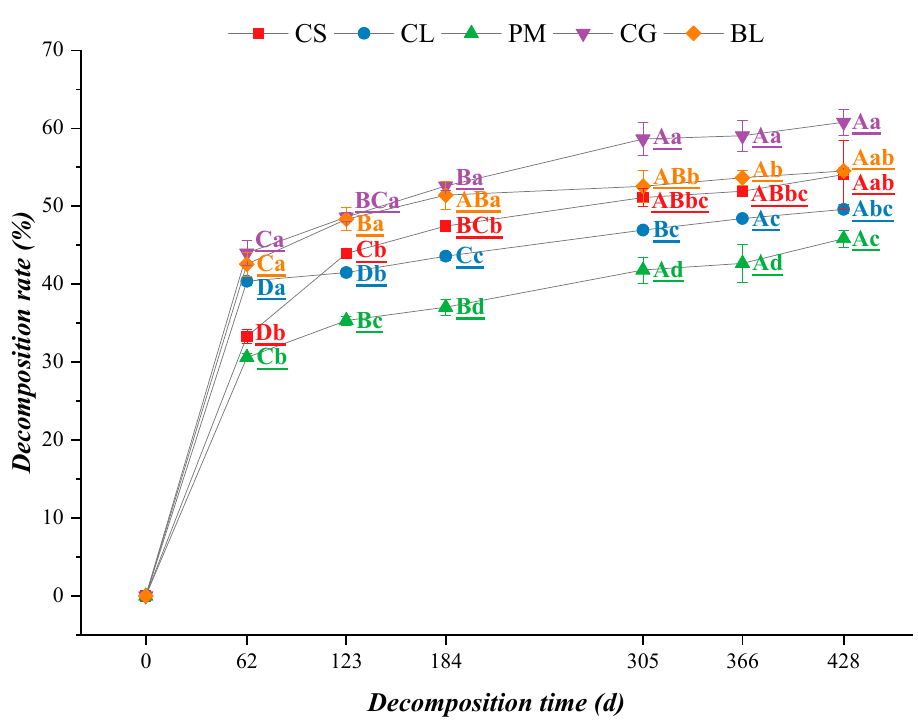
Figure 3. Variation characteristics of the decomposition rates of different litters with decomposition